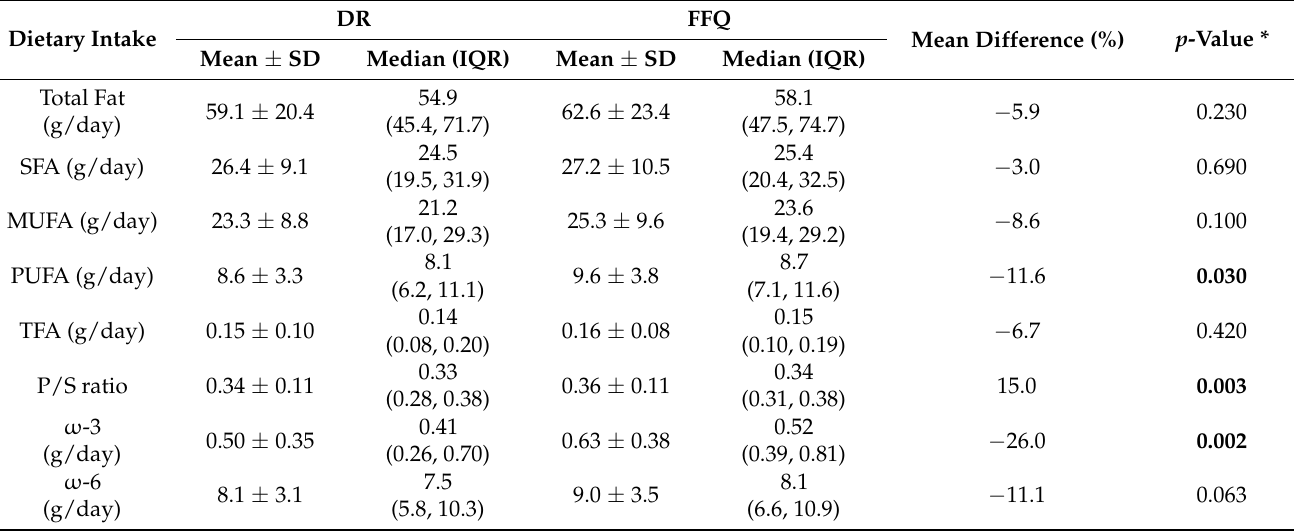
Table 2. Total Fat and Fatty Acid Intake by Dietary Assessment